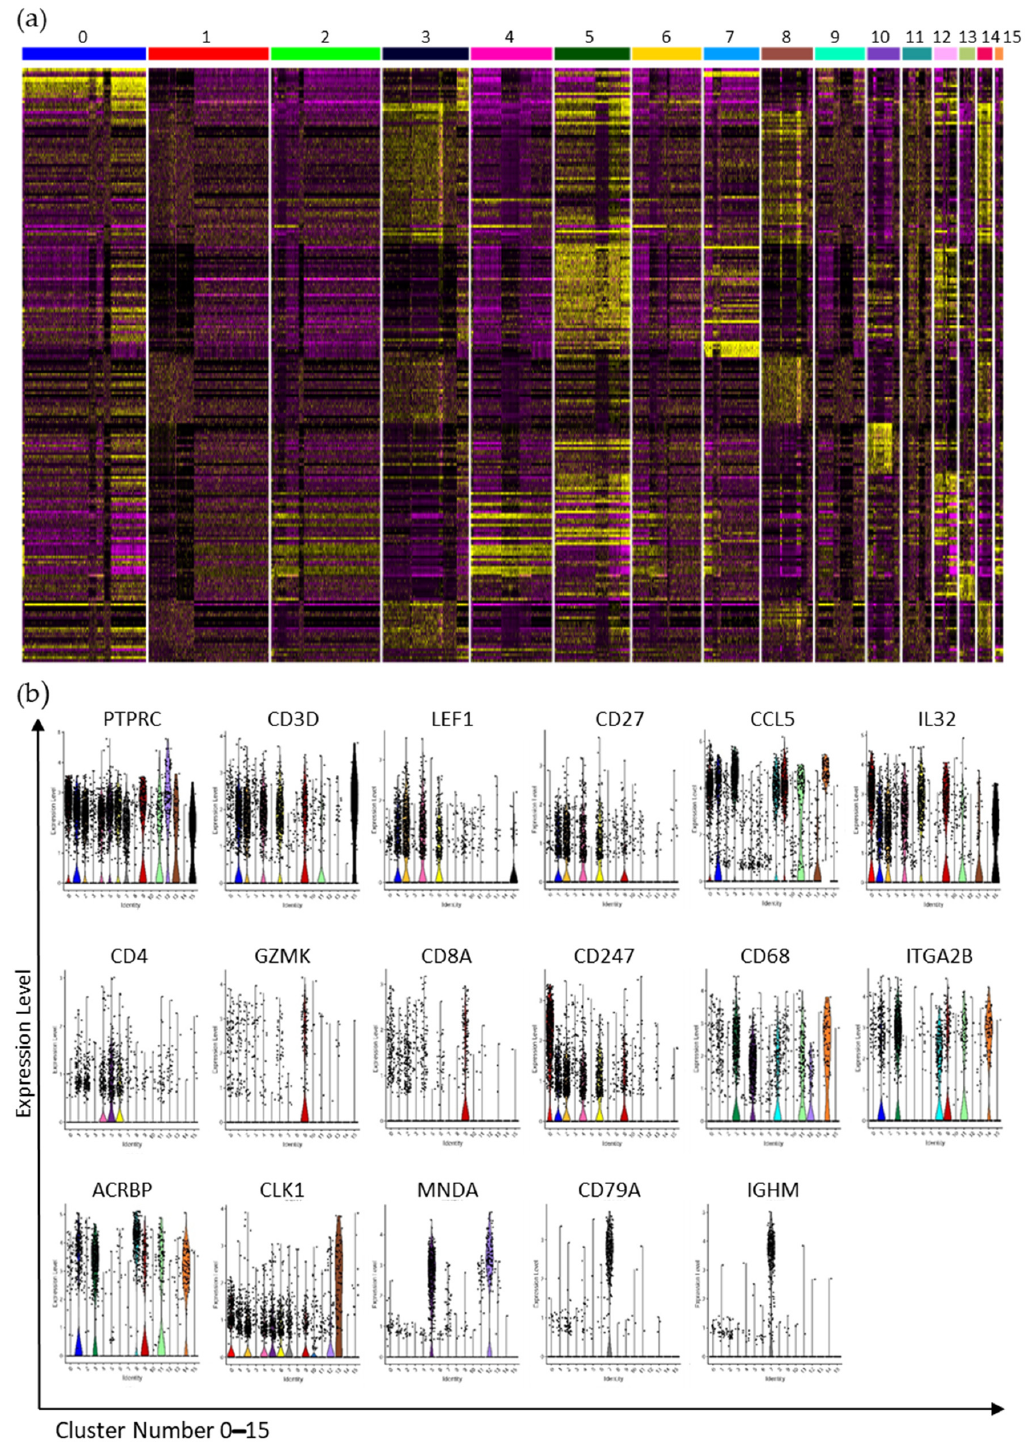
Figure 5. Gene expression of biomarkers in individual cells within each cluster for identification of genes of interest. ( a ) Heat map of gene expression in the 16 clusters determined by scRNA-Seq. Genes that were significantly expressed across samples and denoted as biomarkers were used for cluster identification. ( b ) Violin plots of some of the biomarker genes used for the identification of cell